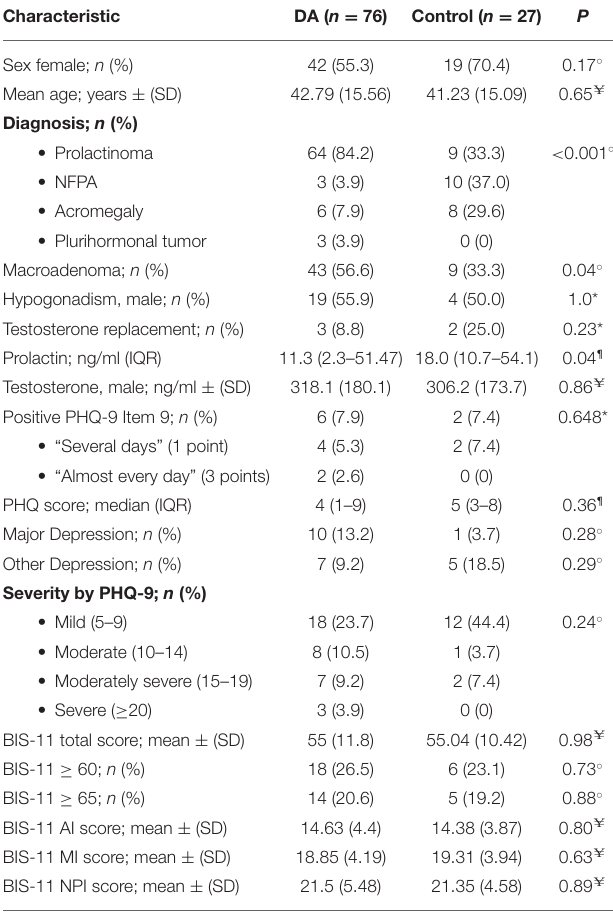
TABLE 1 | Demographic characteristics and survey